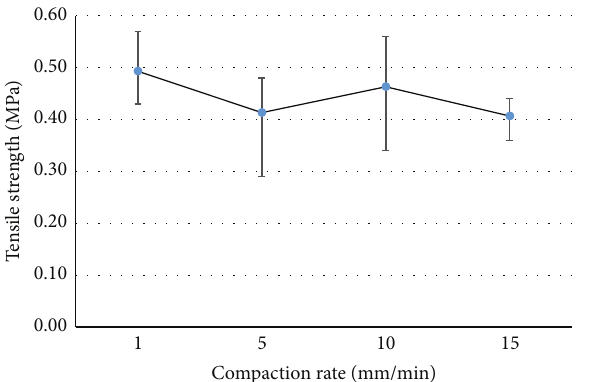
Figure 12: Correlation between tensile strength and density.